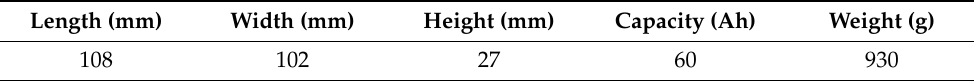
Table 1. Specifications of the